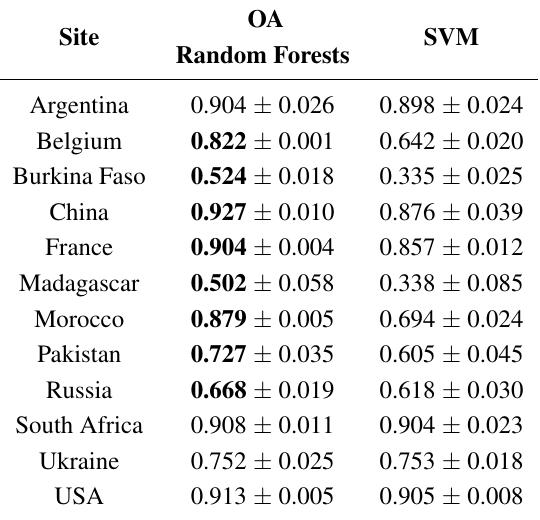
Table 1. Results for random forests and SVM. OA with 95% confidence intervals. Bold typeface is used to highlight statistically-significant differences between the two classifiers.